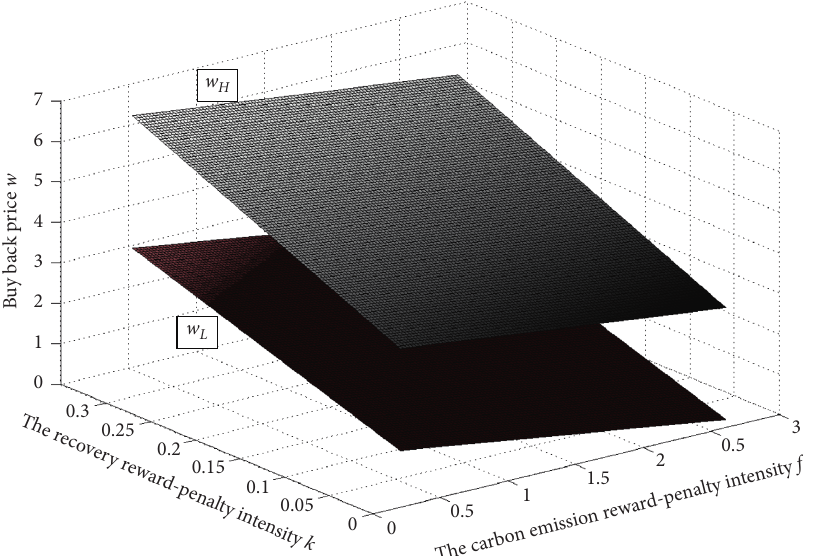
Figure 4: WEEE buyback price w